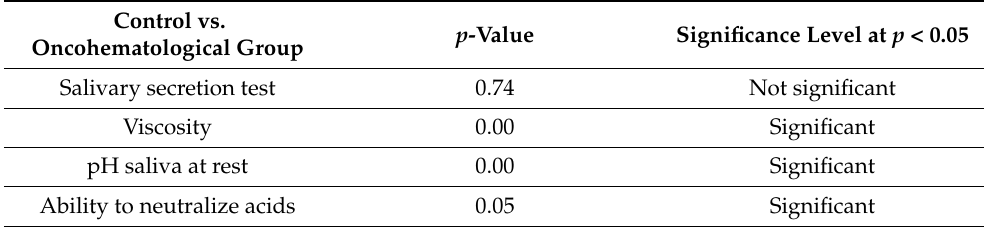
Table 2. Fisher’s exact test for the salivary test executed on controls and oncohematological group [11,12].